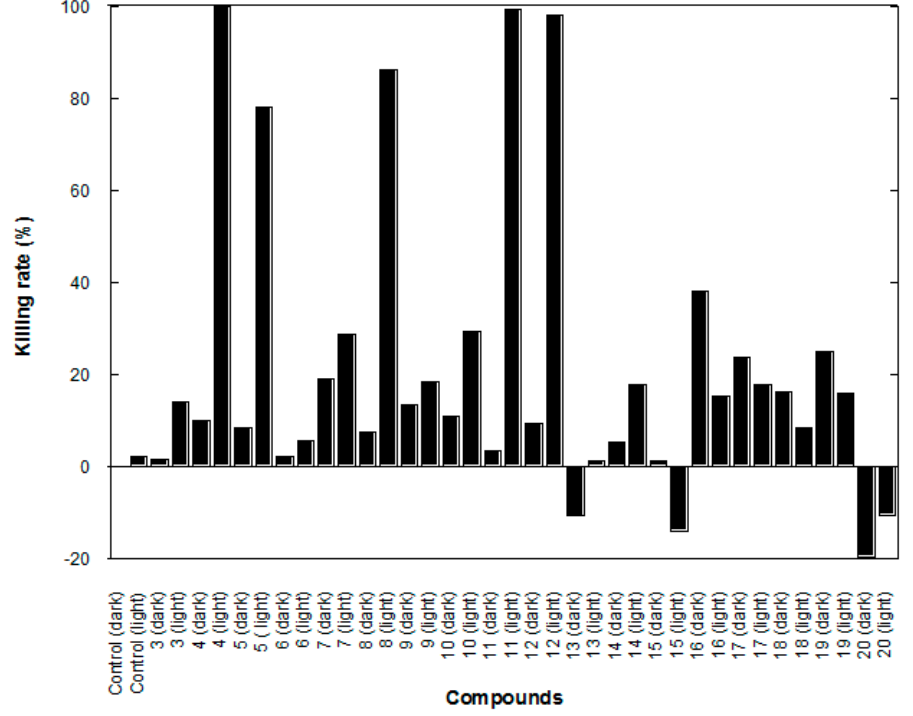
Figure 2. Bacterial killing activities of curcumin analogs on aerobic bacterium Staphylococcus epidermidis .